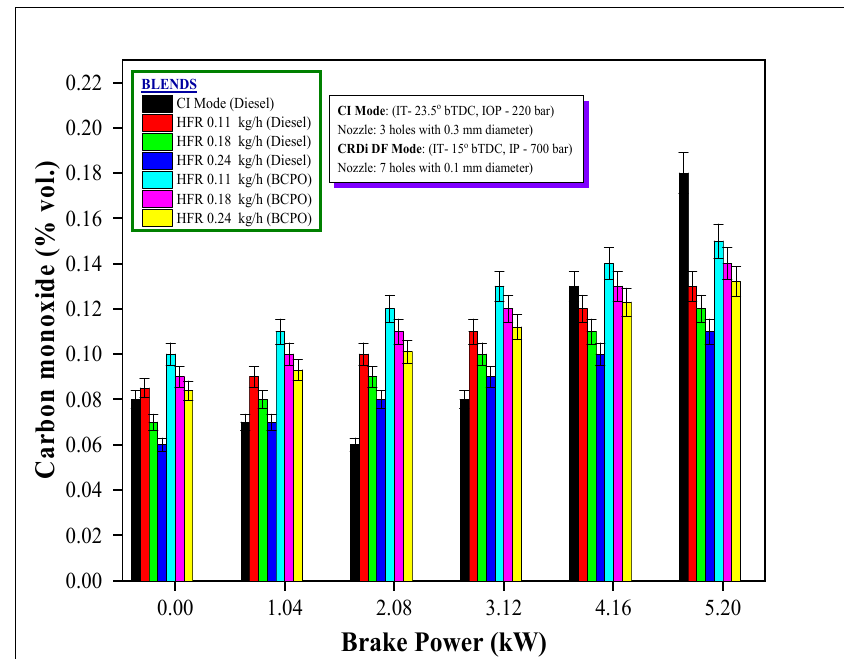
Figure 7. HFR and BP influence on CRDi engine CO emissions. The HFR and BP influence on emissions of NOx in the CRDi engine is shown in Figure 8. At all loads, NOx emission increased at higher HFR. The likely reason could be lower ID and enhanced HRR resulting in raised temperature caused by the higher flame speed of hydrogen combustion. Use of BCPO resulted in NOx reduction because of ID increase and lower HRR. Under the conditions of 80% loading, 17.5 CR and 0.24 kg/h HFR, NOx reduction was better for the CRDi engine as compared to the CI mode of operation. Similar results were revealed in the literature [7,8].